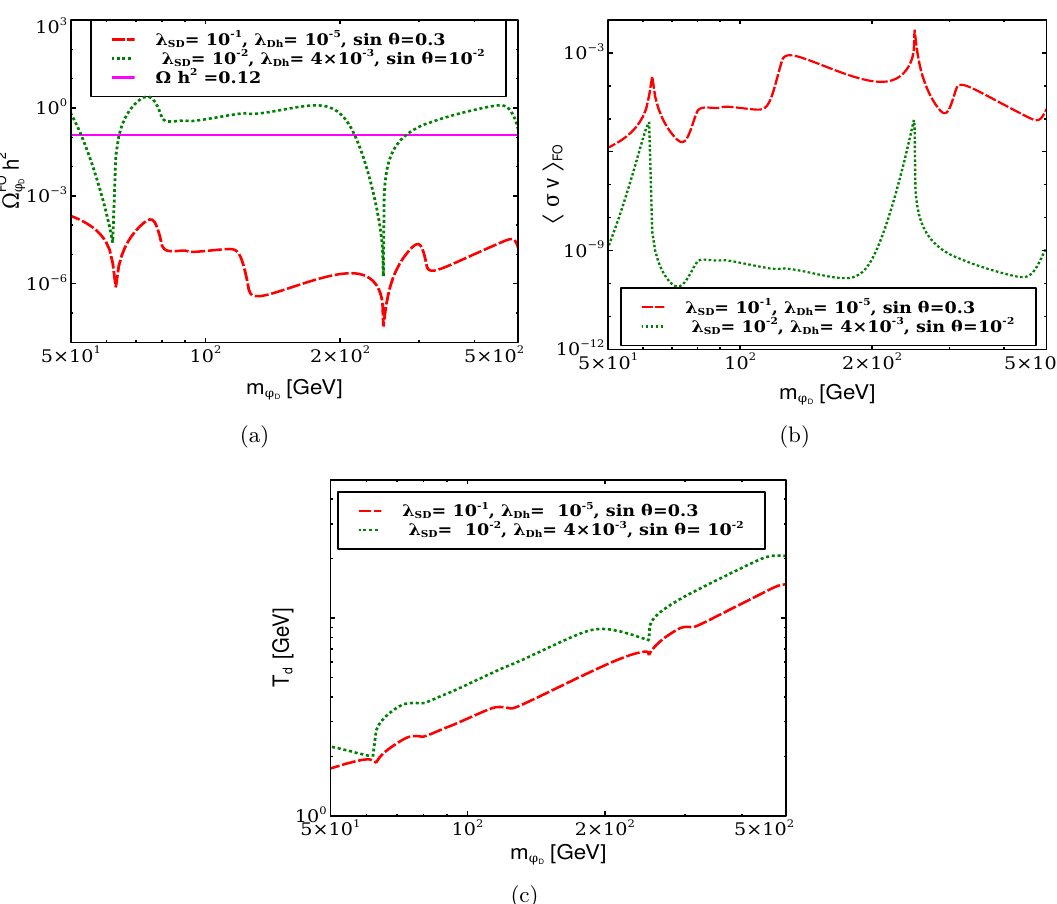
Figure 6 . Figure 6(a), and figure 6(b) represent the variation of Ω FO φ D , and figure 6(c) represent the variation of the freeze-out temperature of φ D w.r.t. its